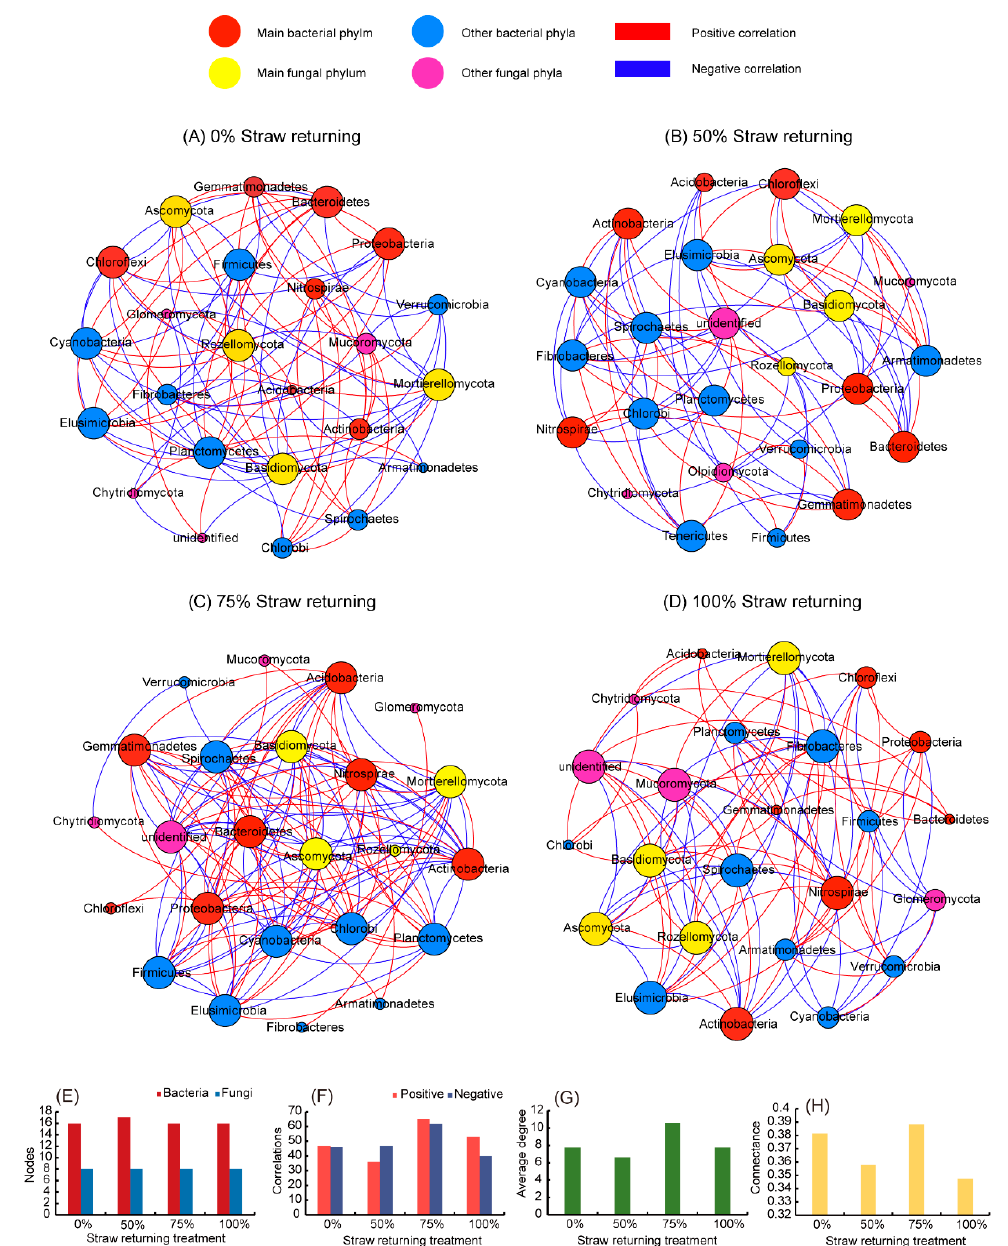
Figure 4. Network analysis between bacterial and fungal communities in fields treated with different amounts of straw. ( A ) network correlation between bacteria and fungi in no straw addition; ( B ) network correlation between bacteria and fungi in 50% straw addition; ( C ) network correlation between bacteria and fungi in 75% straw addition; ( D ) network correlation between bacteria and fungi in 100% straw addition; ( E ) Number of nodes; ( F ) number of edges; ( G ) network average degree; ( H ) network complexity. The red and blue nodes represent the bacterial phyla, and the red nodes are the main bacterial phyla; the yellow and pink nodes are the fungal phyla, and the yellow nodes represent the main fungal phyla. The red lines indicate a positive correlation, and the blue lines indicate a negative